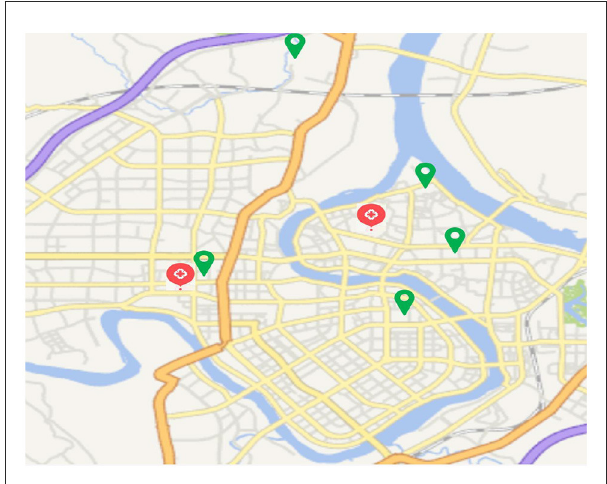
FIGURE1 The locations of air pollutant data monitoring sites (green symbol) and hospital admissions (two campuses, red